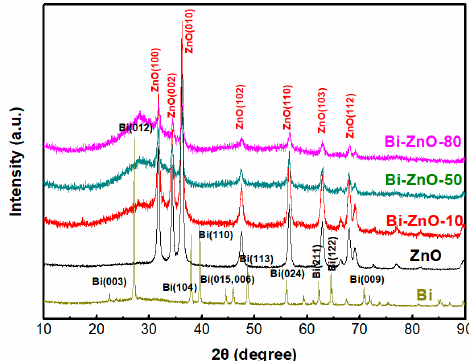
Figure 1. XRD (X-ray diffraction pattern) spectrums of ZnO, Bi and BiNPs/ZnO with different Bi